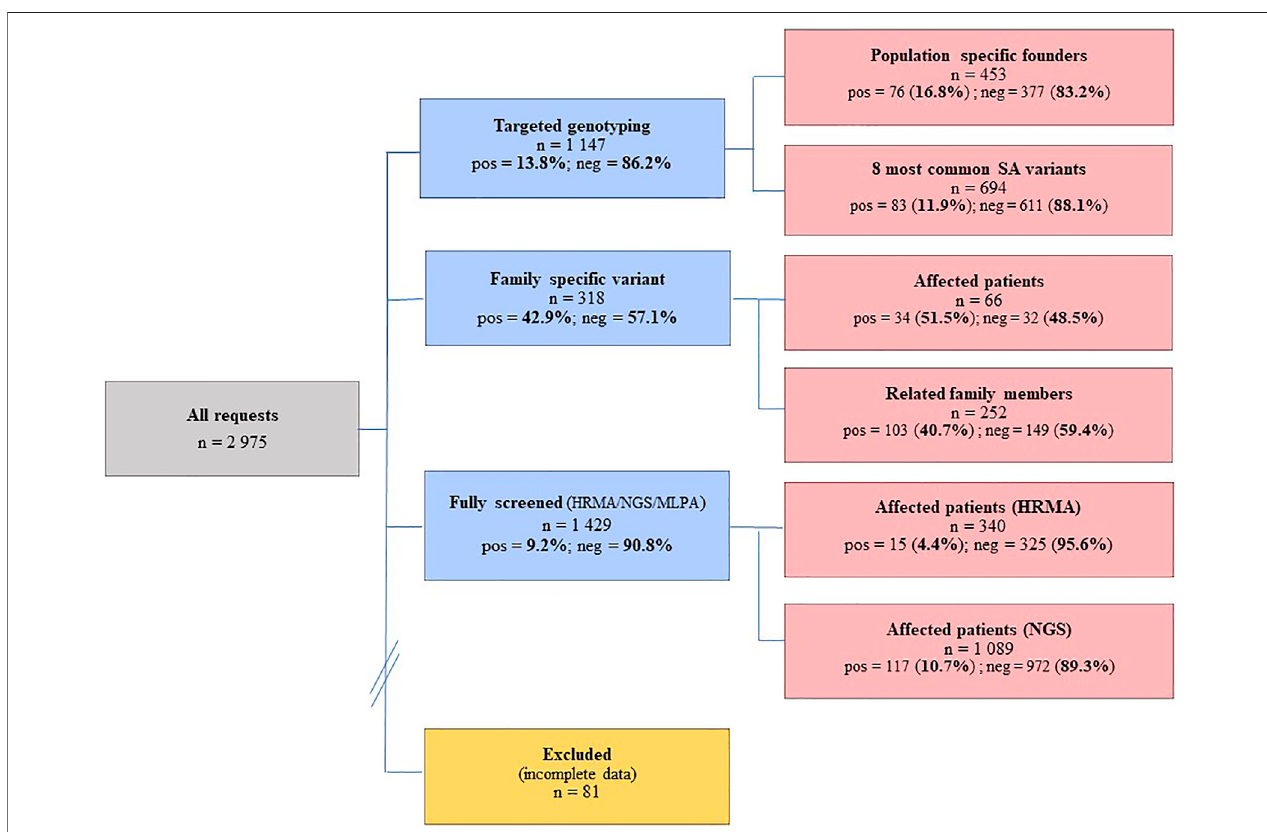
FIGURE 1 | Individuals screened at the NHLS Human Genetics laboratory in Bloemfontein between 1998 and 2020, using a combination ofinvestigative methods ranging from targeted genotyping to comprehensive screening. The numbers screened together with the success rates are indicated. Pos, positives; neg, negatives; HRMA, high resolution melting analysis; NGS, next-generation sequencing; MLPA, multiplex ligation-dependent probe ampli fi cation.